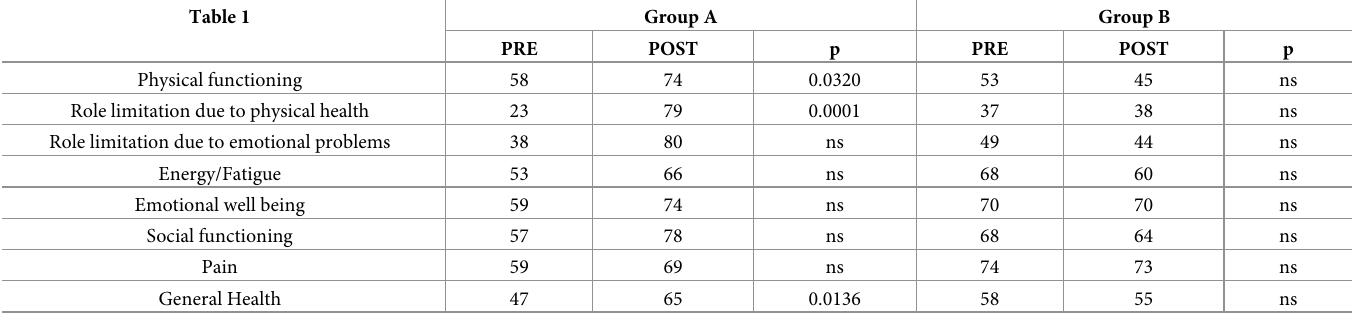
Table 1. Results obtained by the health questionnaire SF-31 standard in group A and B. The results show a significant improvement in the group as regards the physi- cal function, the limits imposed by the disease, emotional problems and overall, the opinion about the disease. Significance was calculated by χ 2 tests. Table 1 Group A Group B PRE POST p PRE POST p